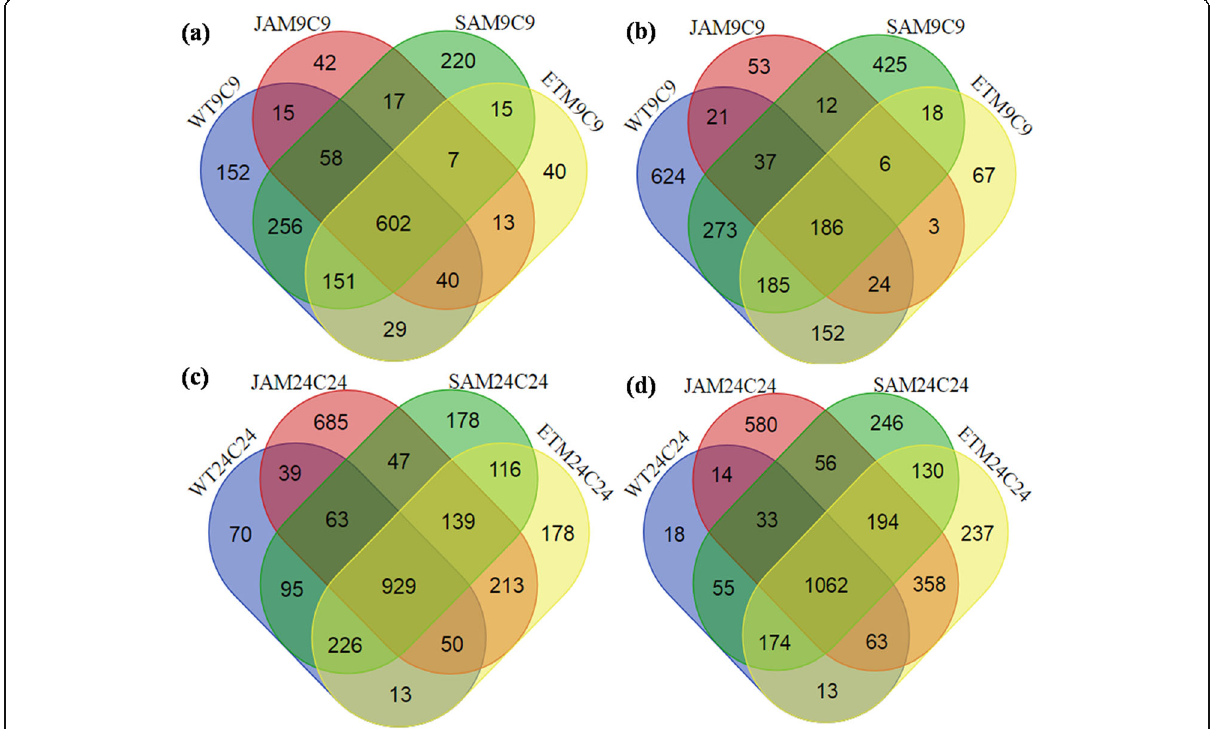
Fig. 2 Venn diagram of unique and commonly expressed genes at a 9h upregulation. b 9h downregulation. c 24h upregulation. d 24h